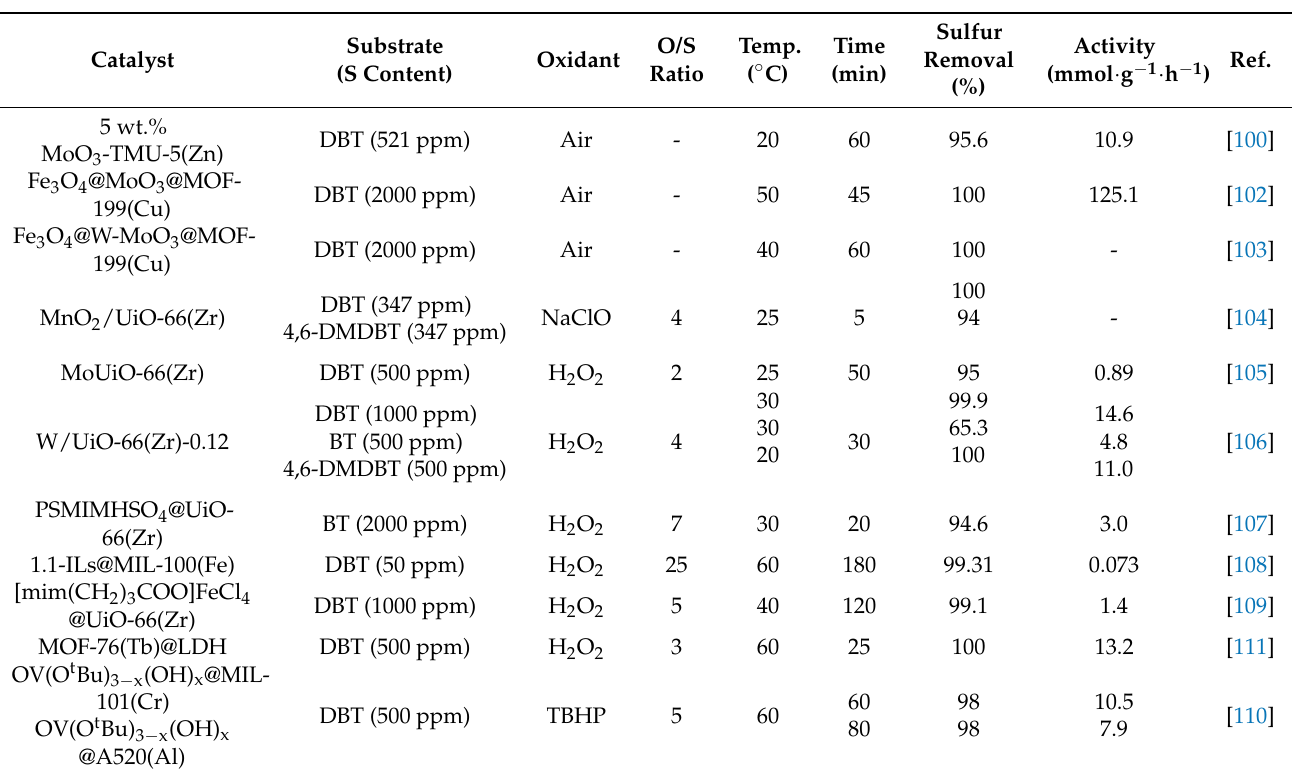
Table 5. Comparison of catalytic performance over the composites of MOFs and other active species in the ODS reactions of model fuel